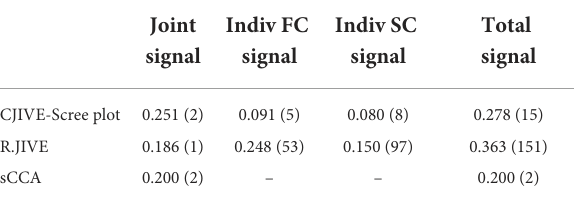
TABLE 3 Multiple regression of fluid intelligence onto joint subject scores estimated with CJIVE-Scree plot, R.JIVE, and sCCA. AJIVE and CJIVE are equivalent as both methods selected two joint components. Numbers in parentheses indicate the